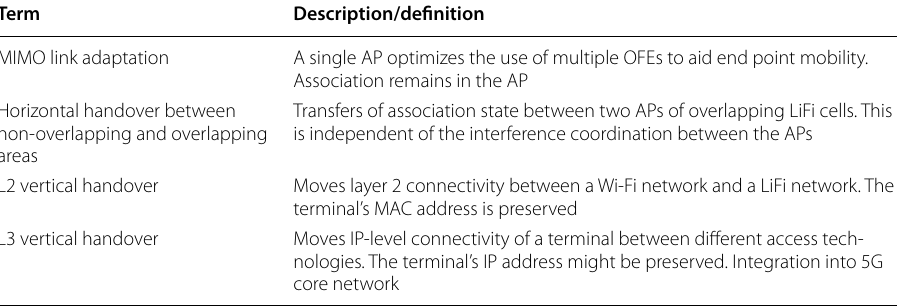
Fig. 10 Handover scenarios between LiFi, Wi-Fi and 5G